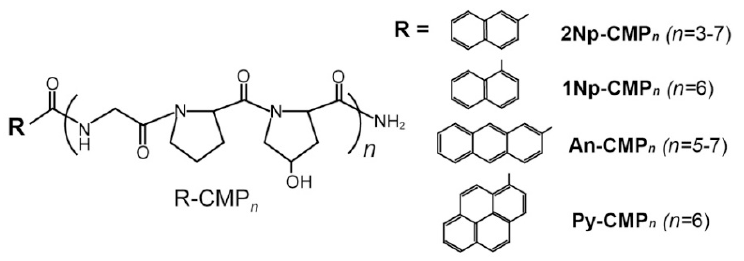
Figure 1. Chemical structures of the collagen-mimetic peptides bearing various aromatic groups at N -termini: 2Np-CMP n ( n = 3–7), 1Np-CMP n ( n = 6), An-CMP n ( n = 5–7), Py-CMP n ( n = 6).